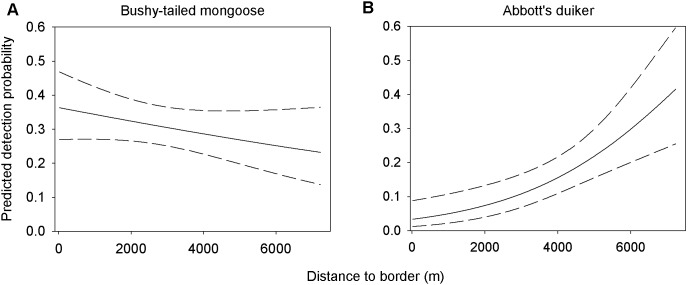
Graphs of predicted detection probability.Values are modelled with distance from the park border for (A) the bushy-tailed mongoose, and (B) the Abbott’s duiker, in the Udzungwa Mountains of Tanzania. Confidence intervals are indicated by dashed lines.